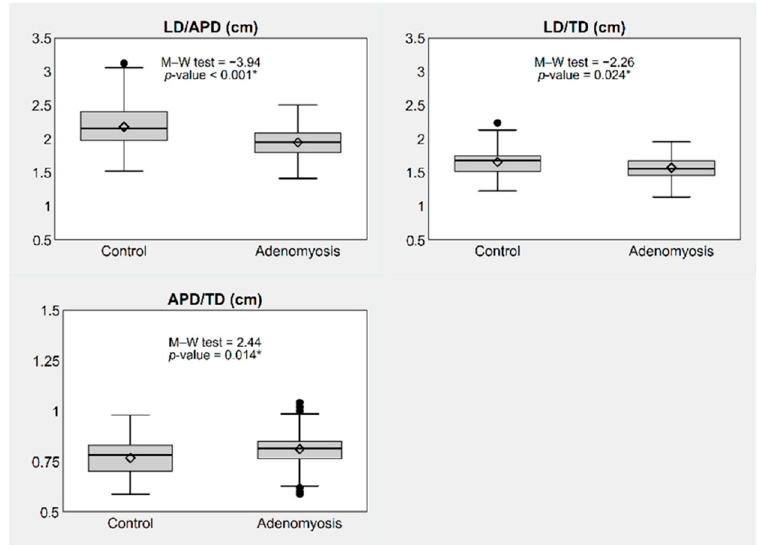
Figure 3. Box plots showing simple diameter ratios of the uterus, by presence or absence of adenomyosis. * p -value ≤ 0.05. Notes: The box represents the interquartile range (IQR), i.e., the distance between the 1st and the 3rd quartile (Q1, Q3); the bar and diamond inside the box represent the median and the mean, respectively; the whiskers represent the lower and upper adjacent values, i.e., the lowest observation ≥ Q1 − 1.5 × IQR and the largest observation ≤ Q3 + 1.5 × IQR; the circles represent the individual values observed outside the whiskers (outliers). Abbreviations: LD, longitudinal diameter; APD, antero-posterior diameter; TD, transverse diameter.